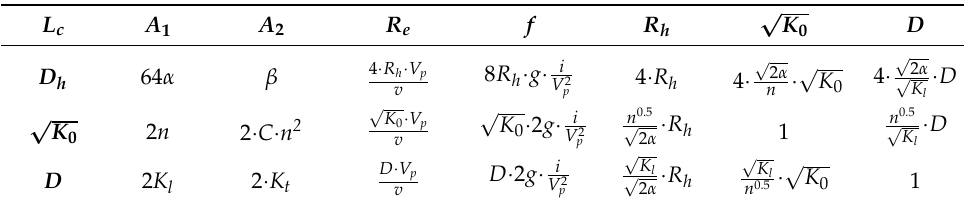
Table 1. Relationships among characteristic lengths L c